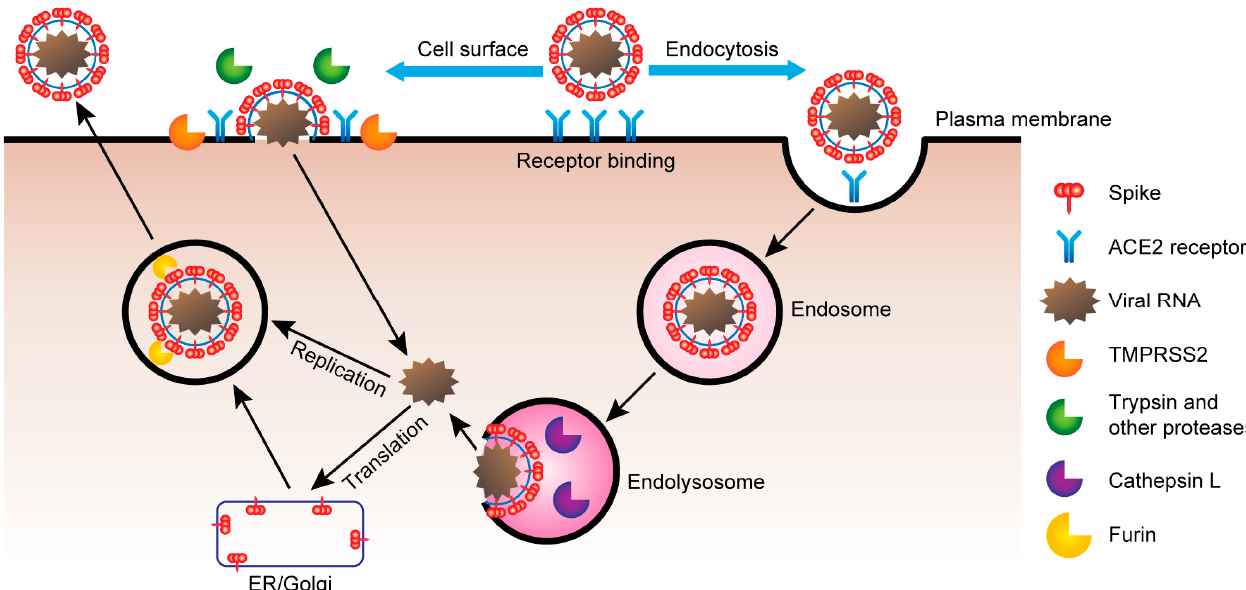
Figure 3. Coronavirus entry mechanisms. ACE2 is a transmembrane protein and is a main receptor for SARS ‐ CoV ‐ 2. After binding to ACE2 the virus enters the cell where it co ‐ opts to diverse cellular functions. Viral spike protein binds to ACE2 on responsive cells. Virus spike protein is either processed by TMPRSS2 and other serine proteases, facilitating cell surface entry, or endocytosis into endosomes, where spike is processed by cathepsin L (CTSL) in the lysosome. Viral RNA is replicated as partial and complete genome copies and translated in the ER to form new SARS ‐ CoV ‐ 2 virions. Processing of spike protein by furin occurs prior to release of new viruses into the extracellular environment. ACE2, angiotensin converting enzyme 2; CTSL, cathepsin L; ER, endoplasmic reticulum; NRP1, Neuropilin 1; SARS ‐ CoV ‐ 2, Severe Acute Respiratory Syndrome Coronavirus 2 [96].